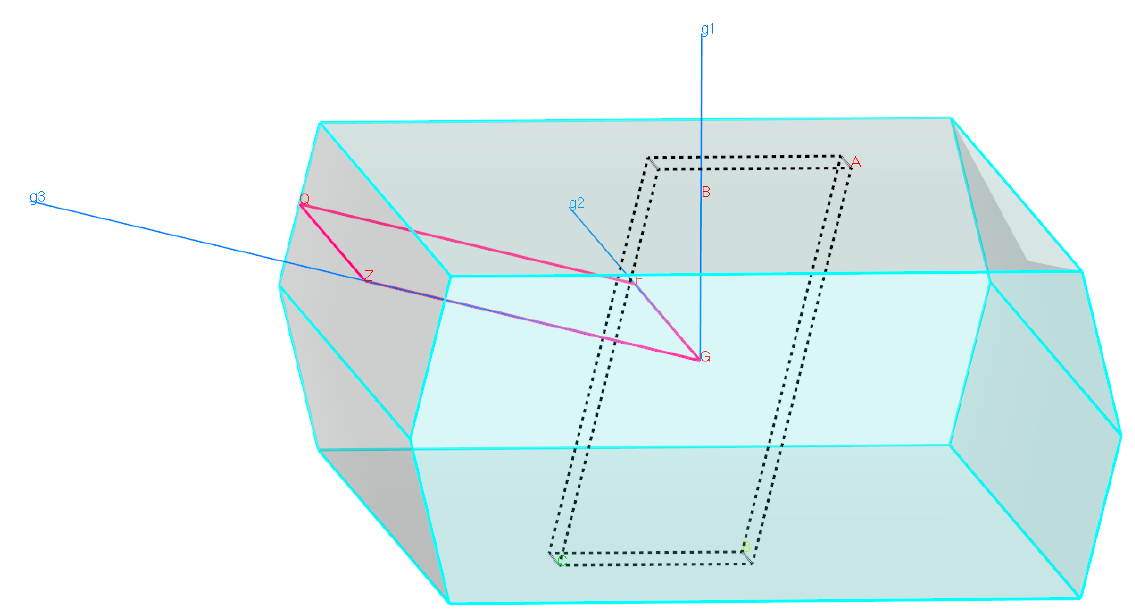
Figure 4. Brillouin zone path at G-F-G-Z-Q direction for β -Ga 2 O 3 in P1 symmetry.